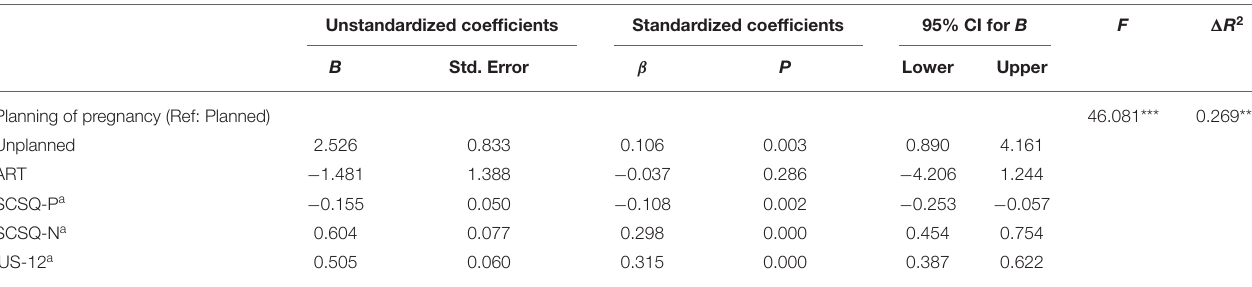
TABLE 5 | Results of linear regression for predicting FOC of nulliparous women ( N =